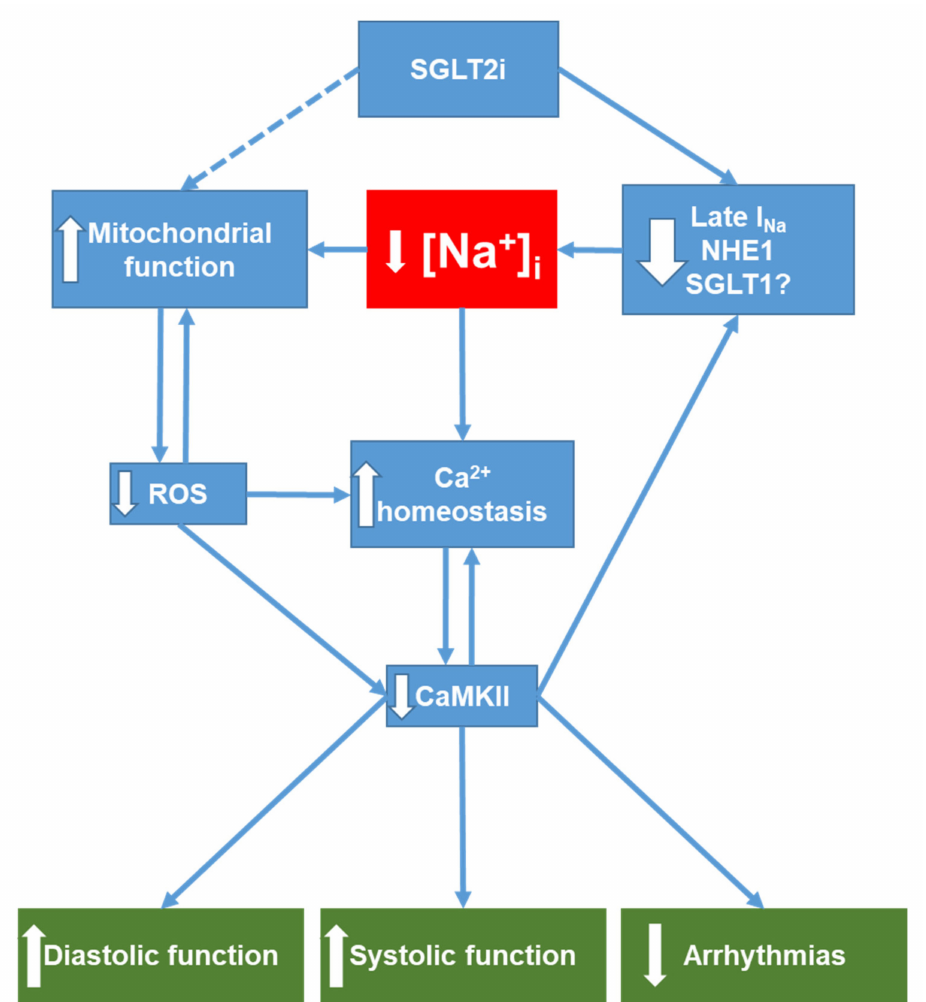
Figure 3. Overview of potential SGLT2i targets relevant for ion homeostasis in the heart. SGLT2i directly reduces (via inhibition of Late I Na , NHE1 and potentially SGLT1) intracellular Na + accumulation in the failing heart. Decreased [Na + ] i in turn improves mitochondrial function (see Section 4.1) and thus may contribute to the decrease in mitochondrial ROS formation observed with SGLT2i treatment. Reduction of oxidative stress attenuates oxidative CaMKII activation, which, together with decreased [Na + ] i , improves cellular Ca 2+ handling and leads to improved diastolic and systolic function. Moreover, both restoration of Ca 2+ homeostasis and CaMKII inhibition are antiarrhythmic. Downward-pointing arrows denote reduction or inhibition of a signaling pathway. Upward-pointing arrows denote stimulation or enhancement of a pathway. NHE1, Na + /H + exchanger 1; SGLT1, sodium-glucose co-transporter 1; ROS, reactive oxygen species; CaMKII, Ca 2+ /calmodulin-dependent protein kinase II; [Na + ] i , cytosolic Na +